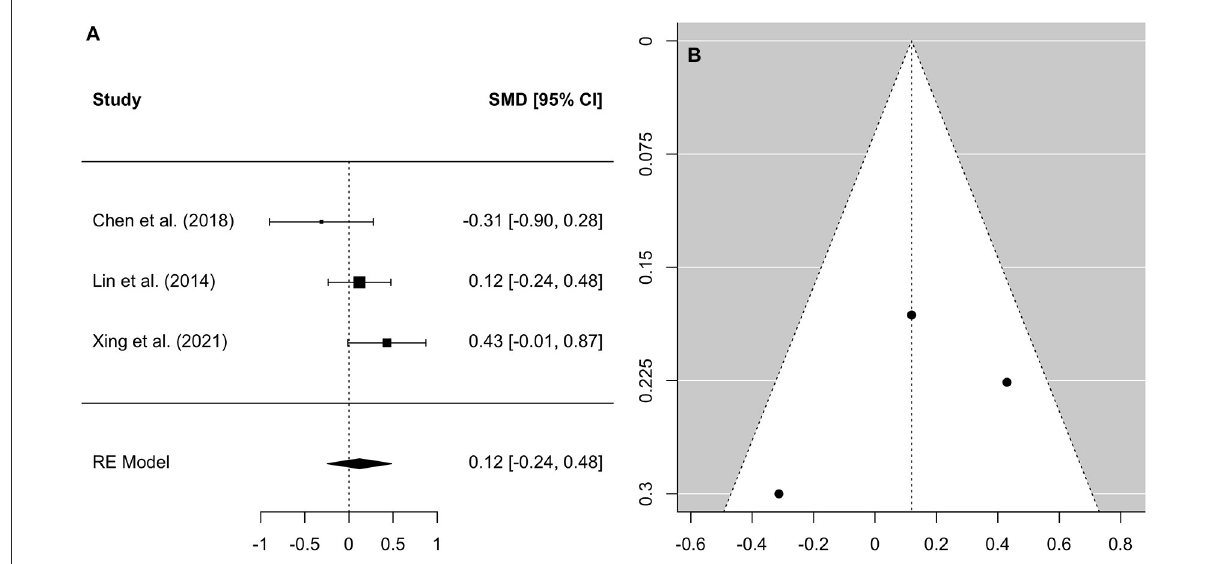
FIGURE2 Forest plot (A) and funnel plot (B) of the whole-brain Analysis. In the forest plot (A) negative values on the x-axis indicate gray matter atrophy.